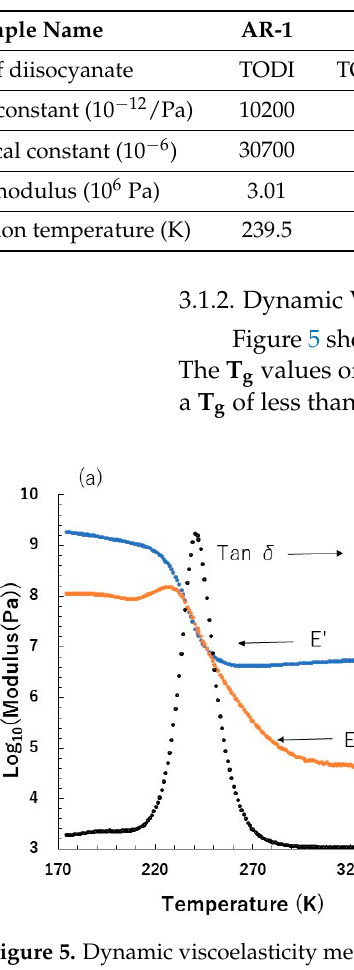
Table 3. Properties of synthetic polyurethane.